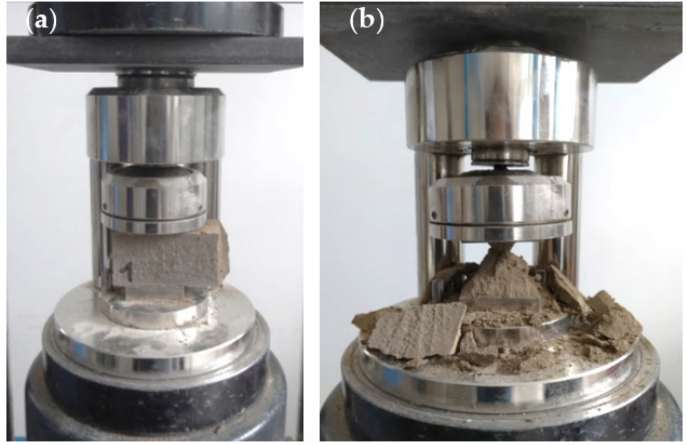
Figure 14. Unconfined compression test on M1–M4 mortar specimens, at the “TecnoLab” labora- tory: ( a ) pre-test; and ( b )